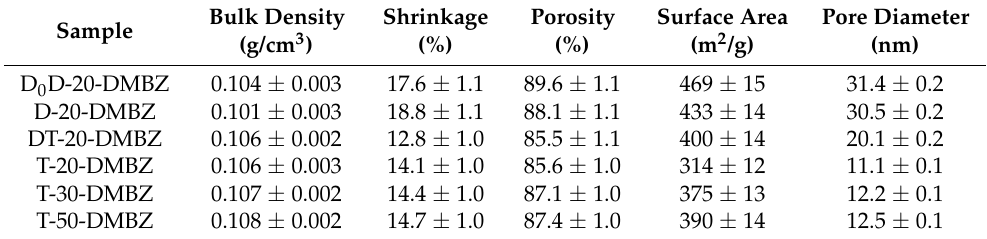
Table 1. Properties of the different PI aerogels investigated in this work.